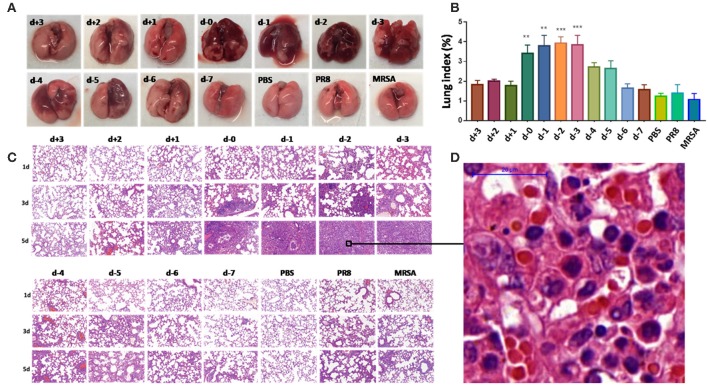
Pathological differences in mice coinfected with influenza virus and methicillin-resistant S. aureus using different infection sequences and times. (A) Anatomy of the lung tissues of coinfected mice with different infection sequences and times. Lung tissue injury in groups d-0, d-1, d-2, and d-3 was significantly more severe than that in the other groups as denoted by the color change from pink to dark purple. (B) The lung indices of mice in groups d-0, d-1, d-2, and d-3 were significantly higher than in the other groups (**p < 0.01; ***p < 0.001, n = 6). (C) Lung pathological sections of coinfected mice with different infection sequences and times (15 × ). Lung injury in groups d-0, d-1, d-2, and d-3 on the fifth day after infection was significantly higher than in the other groups. (D) Local enlarged view of pathological sections of lungs showing severe lung with 100 × magnification. The alveoli showed extensive atrophy or did not dilate. Pulmonary consolidation, in which severe infiltration of inflammatory cells (lymphocytes and granulocytes), was observed. PR8, influenza A virus strain; MRSA, methicillin-resistant S. aureus; PBS, phosphate-buffered saline.